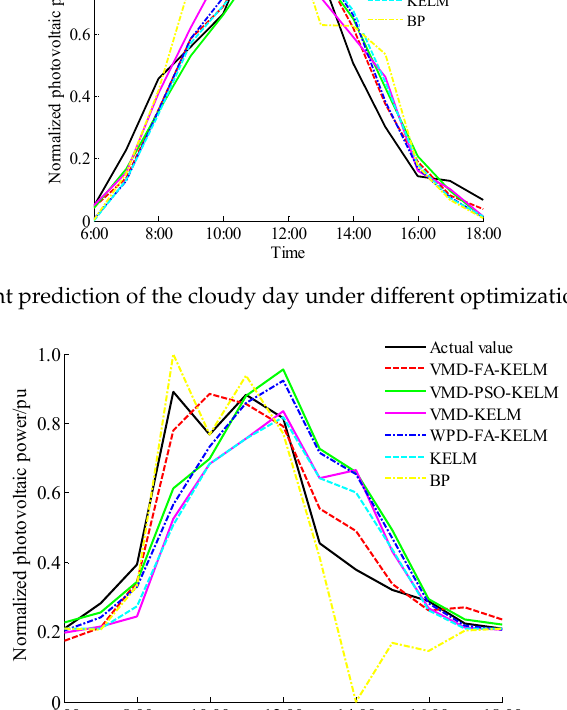
index, and prediction interval normalized averaged width